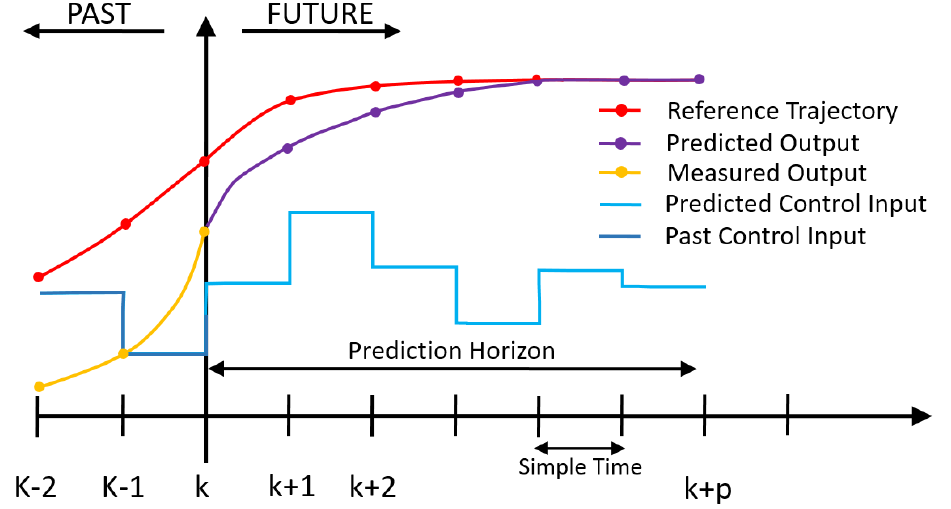
Figure 5. Discrete MPC operating scheme.